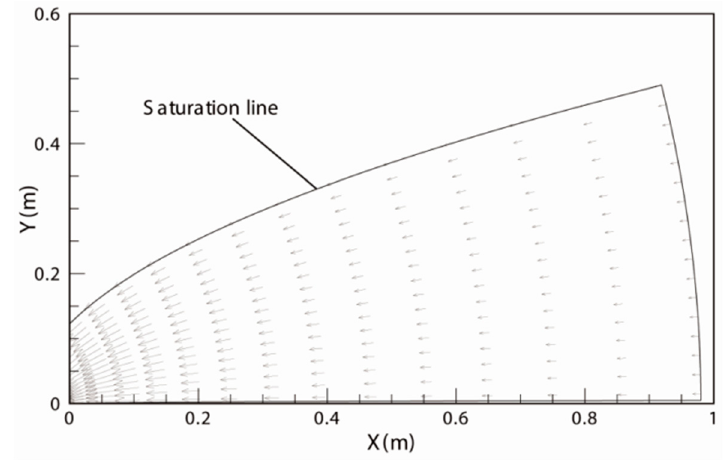
Figure 3. Seepage field of a vertical slope model.